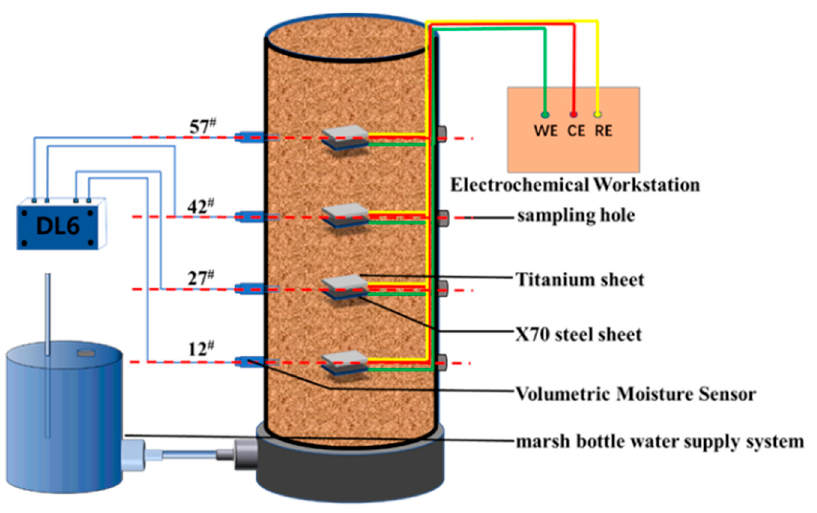
Figure 5. Experimental device.